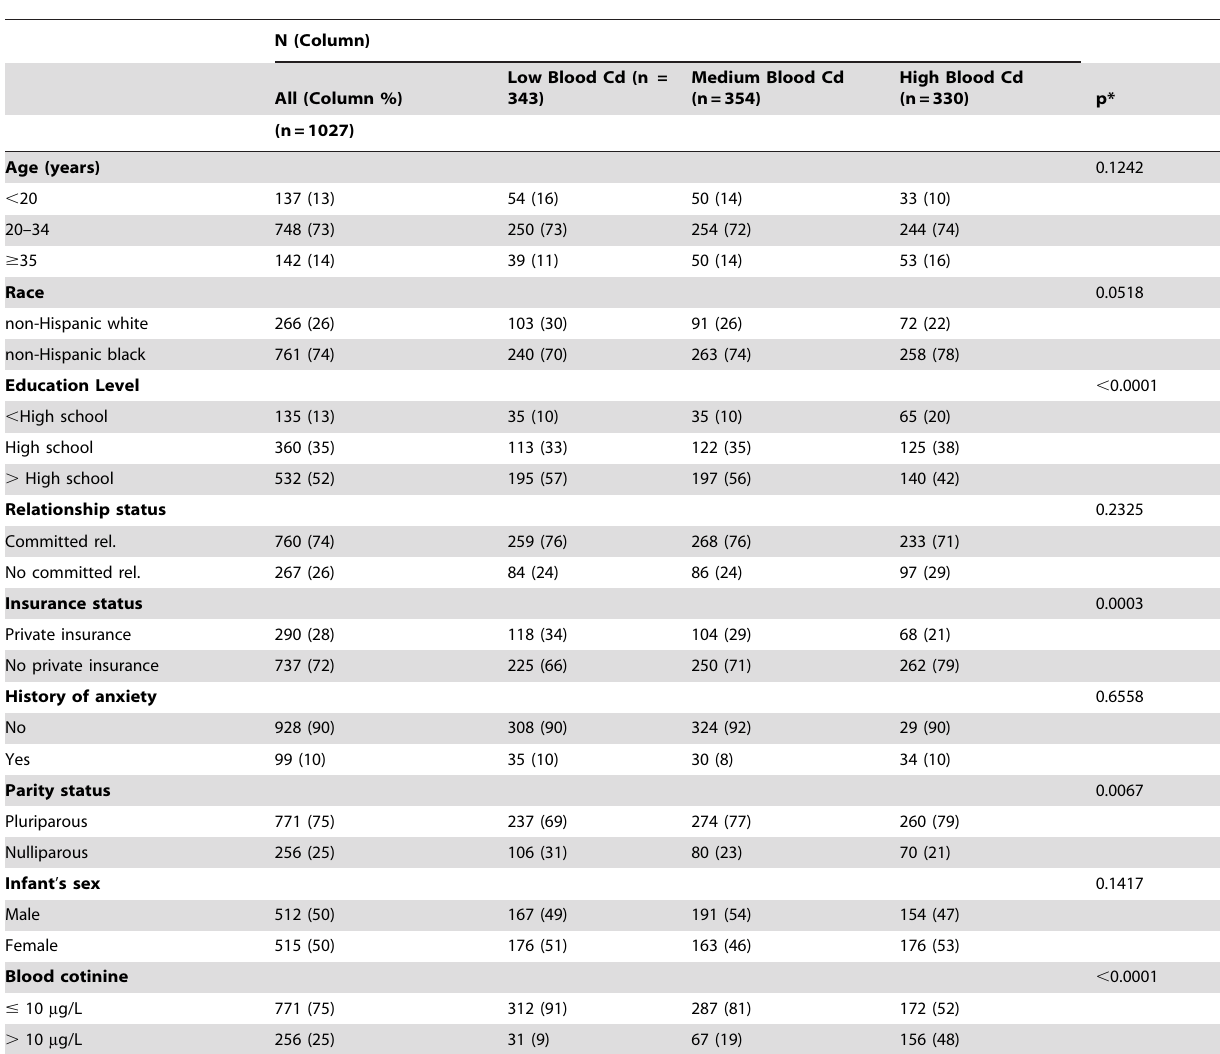
Table 1. Study population